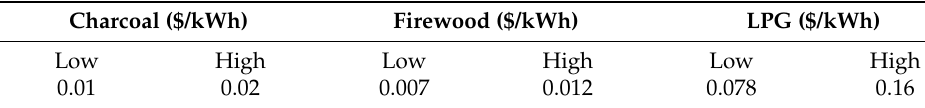
Table 2. Conventional fuel cost.